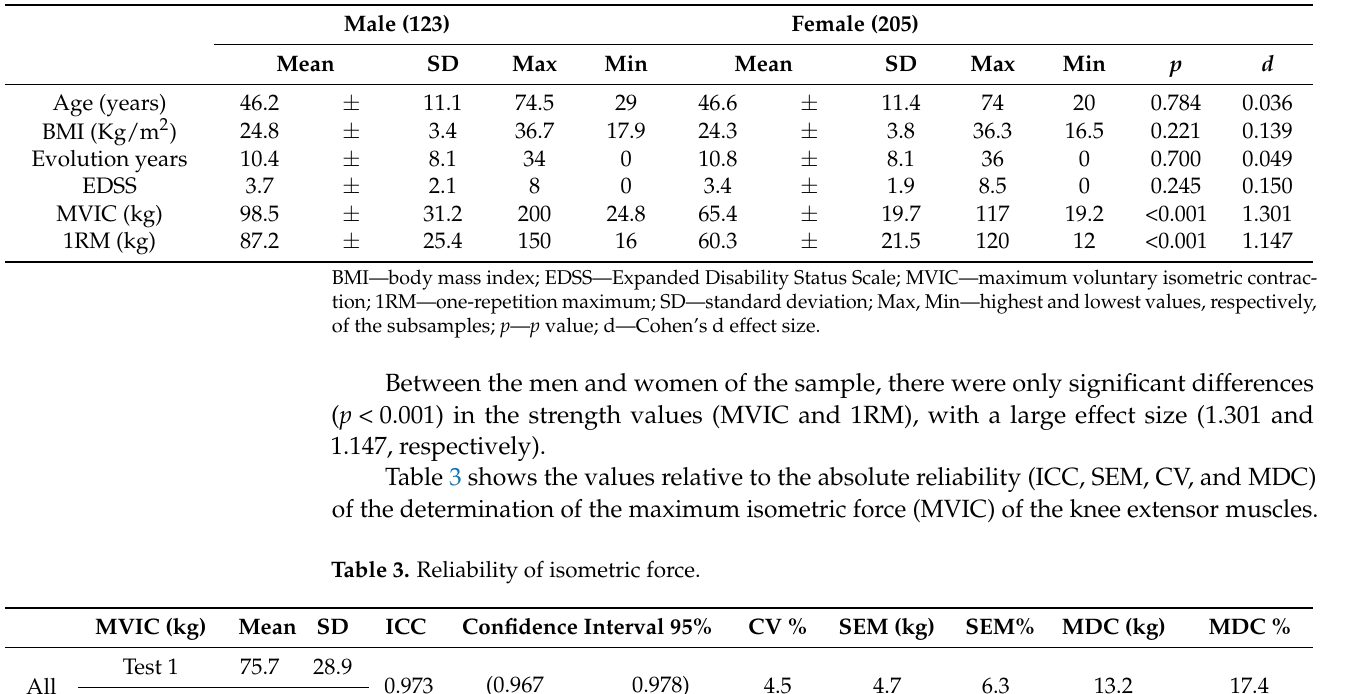
Table 2. Variables of the sample grouped by sex.